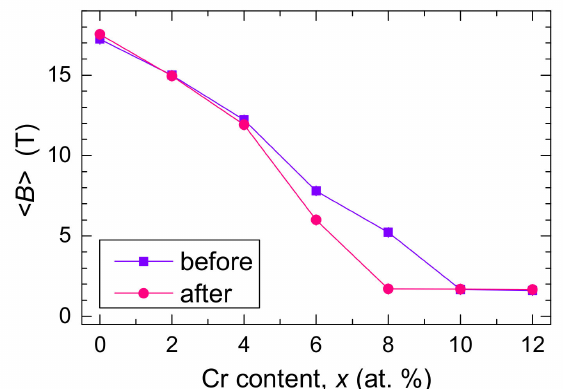
Figure 7. Average hyperfine magnetic fields of P ( B ) distributions, (cid:104) B (cid:105) plotted against Cr content, x , as obtained from Mössbauer spectra of the Fe 30 Ni 48- x Cr x Mo 2 Si 5 B 15 amorphous metallic alloy measured before (violet squares) and after (pink circles) neutron irradiation with the fluence of 10 19 n/cm 2 . Comparison of (cid:104) B (cid:105) values derived from Mössbauer spectra of Fe 30 Ni 48- x Cr x Mo 2 Si 5 B 15 (cid:104) B (cid:105) = (cid:104) B (cid:105) − (cid:104) B (cid:105) , between non-irradiated samples and the corresponding ones non − irr irr